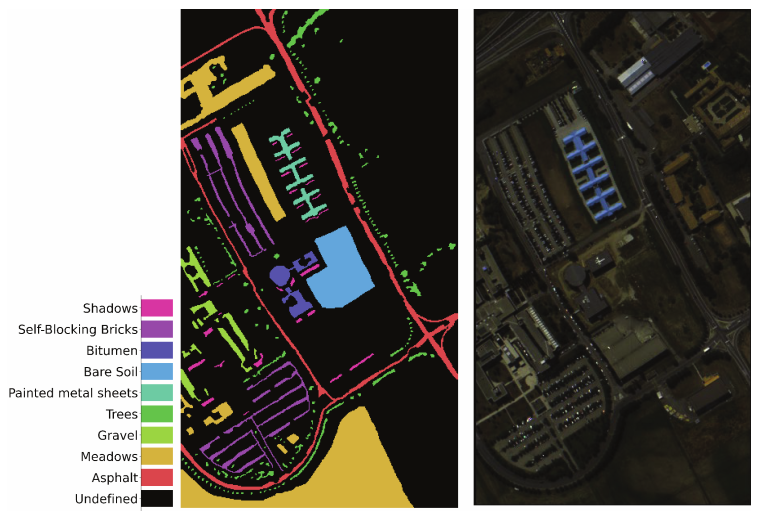
Figure 9. Pavia University dataset: Left is the names of classes, Center is ground truth, Right is the RGB image.